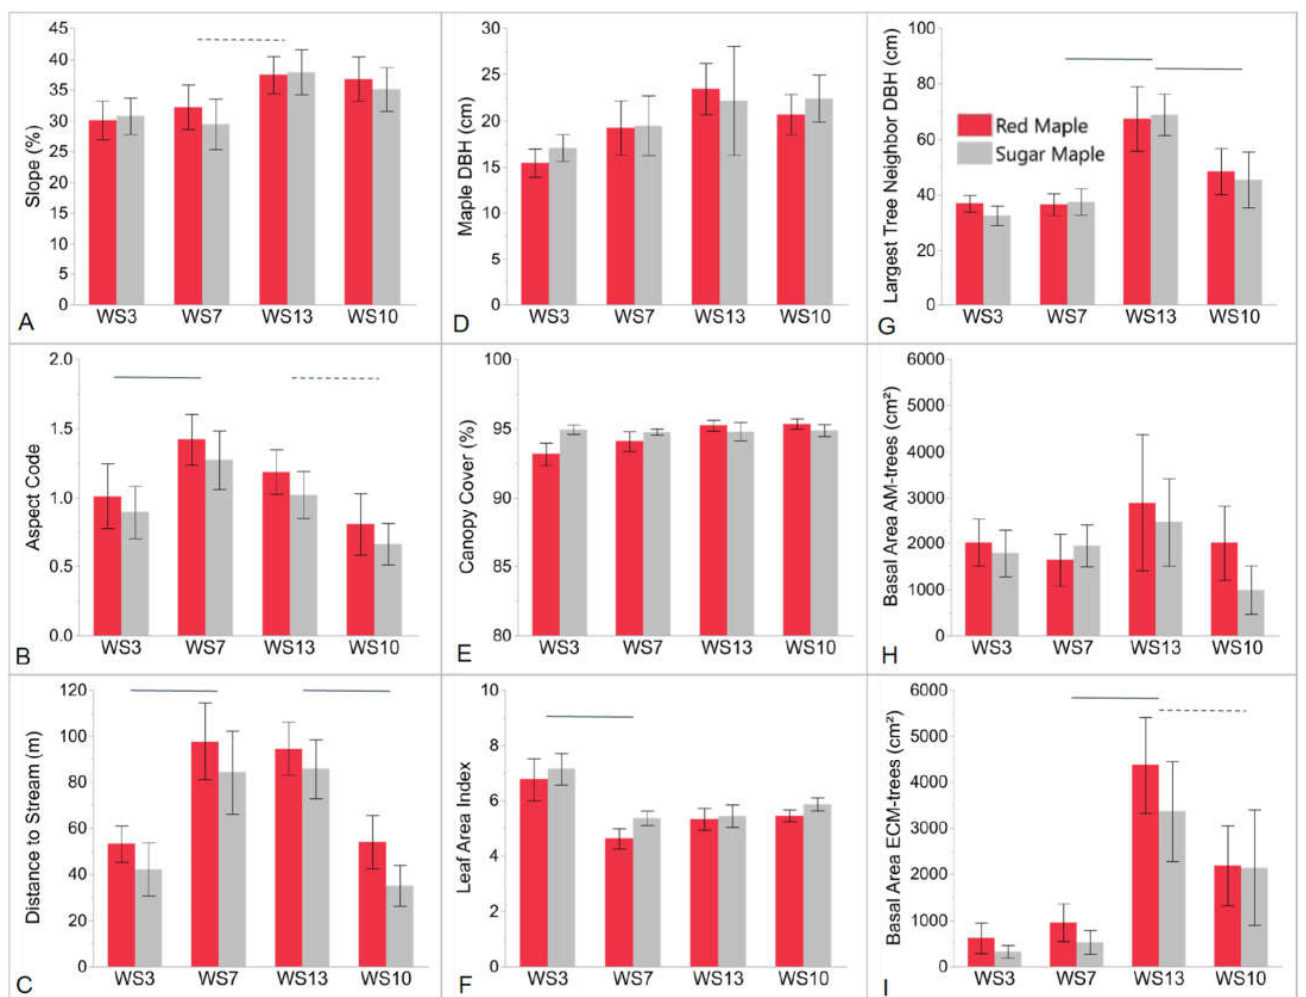
Figure 7. Abiotic and biotic factors potentially influencing study plots under red and sugar maples in each of the watersheds (WS) at the Fernow Experimental Forest, West Virginia, USA. ( A ) Slope measured at each plot, ( B ) plot-level aspect code ranging from 0 to 2, with 0 = southwest (relatively warm, dry) and 2 = northeast (relatively cool, moist), ( C ) slope distance between plot-center and the closest perennial stream, ( D ) diameter at breast height (DBH) of plot-center maples, ( E ) canopy cover measured as crown closure (in July 2018), ( F ) leaf area index (LAI) in Aug/Sep 2019, ( G ) DBH of the largest of the five trees closest to the plot-center maple, and basal area of arbuscular mycorrhizal ( H ) or ectomycorrhizal ( I ) trees among the five trees closest to the plot-center maple. Error bars represent 1 SE ( n = 9). Based on two-way ANOVA containing all four watersheds, followed by least-squares-means contrasts, statistically significant differences between watersheds of watershed pairs are shown by solid lines ( p < 0.05) and dashed lines ( p < 0.1); factor Maple and Watershed × Maple interactions were not statistically significant for any of the environmental variables.